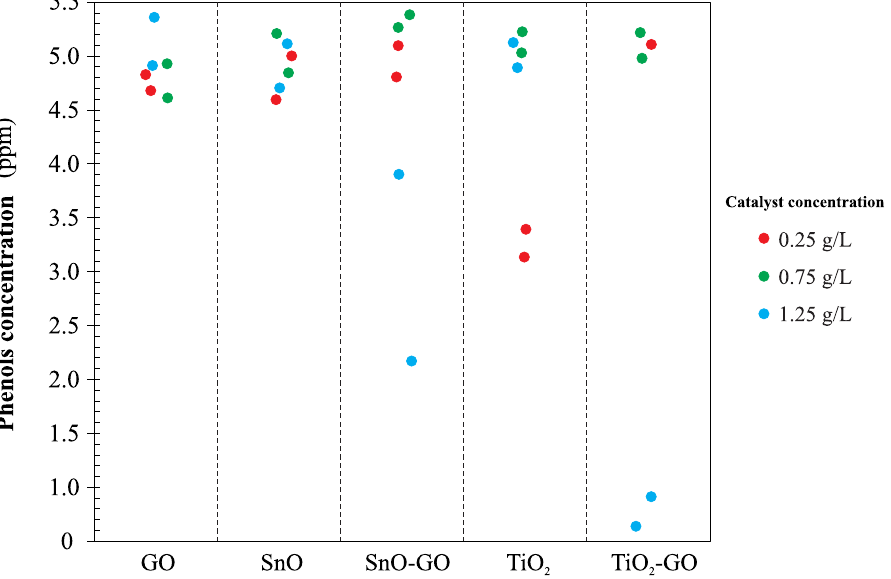
Figure 10. Concentration of phenols in the effluent after the photocatalytic treatment with each one of the catalysts synthesized.